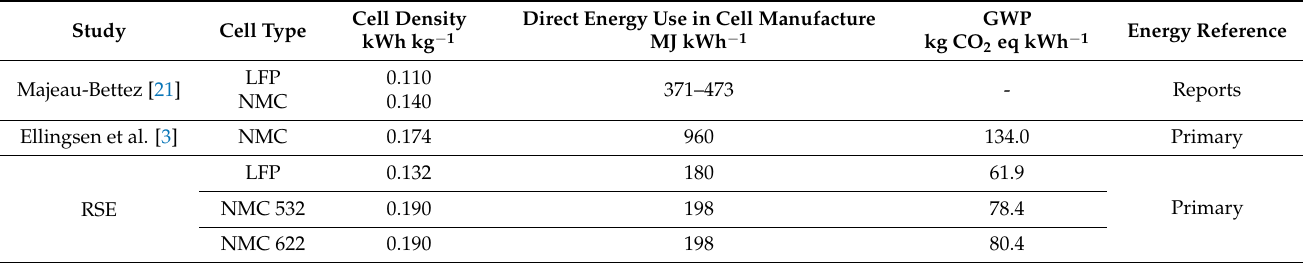
Table 3. Information related to the production of different cell types. GWP: Global Warming Potential, RSE: Ricerca sul Sistema Energetico, that refers to the present